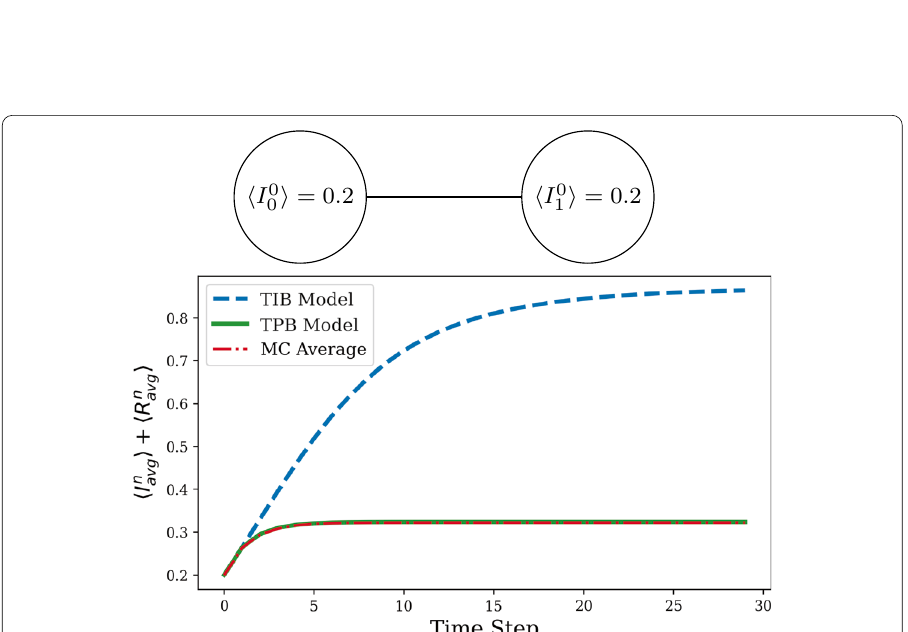
Fig. 1 Running 25 time steps of the TIB (blue dashed) and TPB (green solid) SIR model as well as the average over 10 5 Monte-Carlo (MC) simulations (red dash-dotted) for the two vertex example. Parameters: β = 0.4 , µ = 0.2 , and � I 0 0 � = � I 0 1 � =